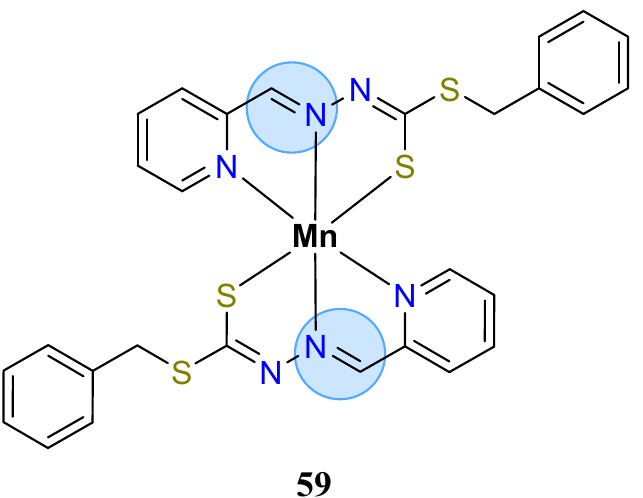
Figure 25. Mn(II) complex from an NNS Schiff base ligand with antimicrobial activity. Refat’s research group reported two SB ligands and their Mn(II) complexes to evaluate their biological properties [134]. Through analytical characterization and molecular modelling, Mn(II) complexes were proposed with an octahedral geometry, where manganese coordinates with ONN/OSO and ONS atoms to generate dinuclear and mononuclear complexes, respectively (Figure 26). To evaluate the antimicrobial activity, only complex 61 was studied. The agar disc diffusion method was used to test the uncoordinated ligands and their metal complexes at a 100 µ g concentration against the Gram-positive strains B. subtilis , S. pneumoniae, and S. aureus , the Gram-negative bacteria E. coli and Pseudomonas